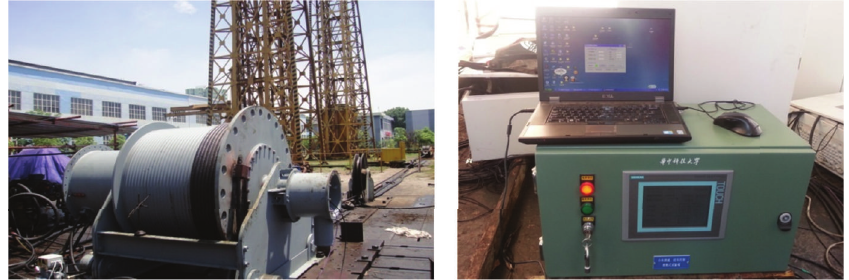
Figure 9: The individual experiment equipments.